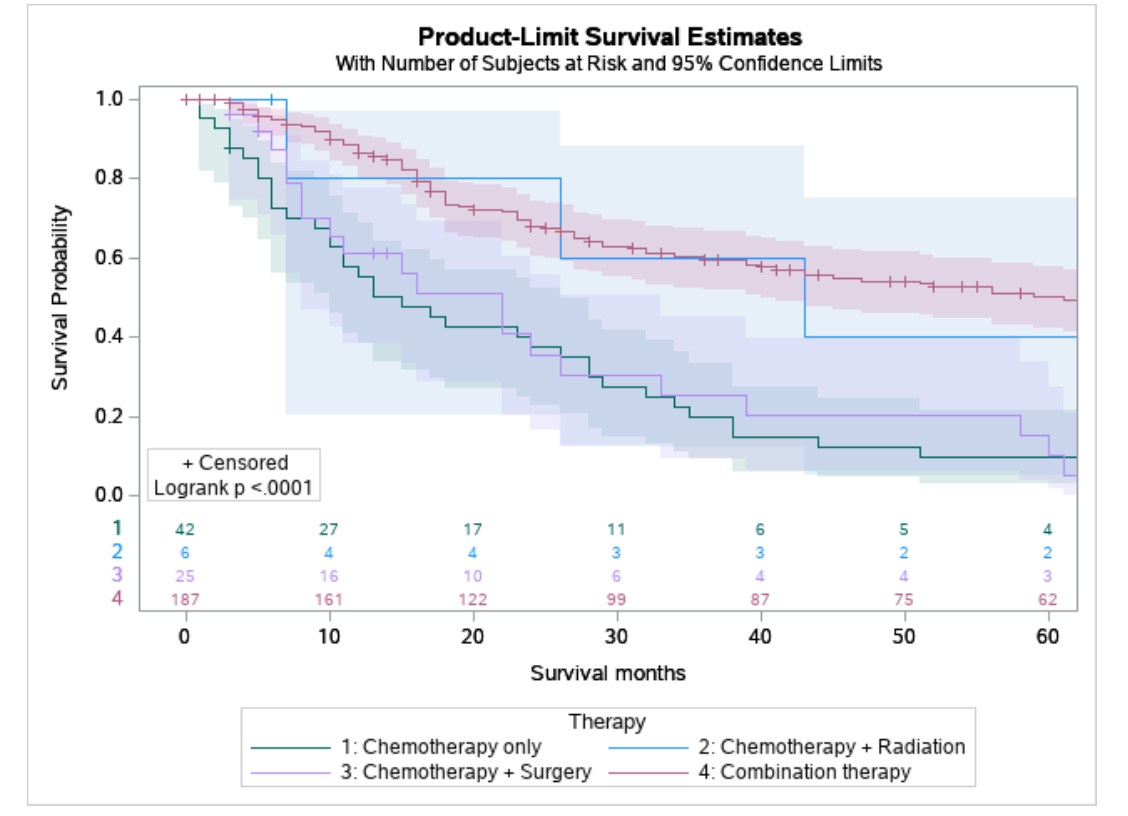
Figure 2. Kaplan Meier graph displaying survival analysis of patients with mucoepidermoid carci- noma (MEC) over the span of 60 months by various treatment modalities involving chemotherapy including chemotherapy only, chemotherapy and radiation, chemotherapy and surgery, and com- bination of surgery, chemotherapy, and radiation.